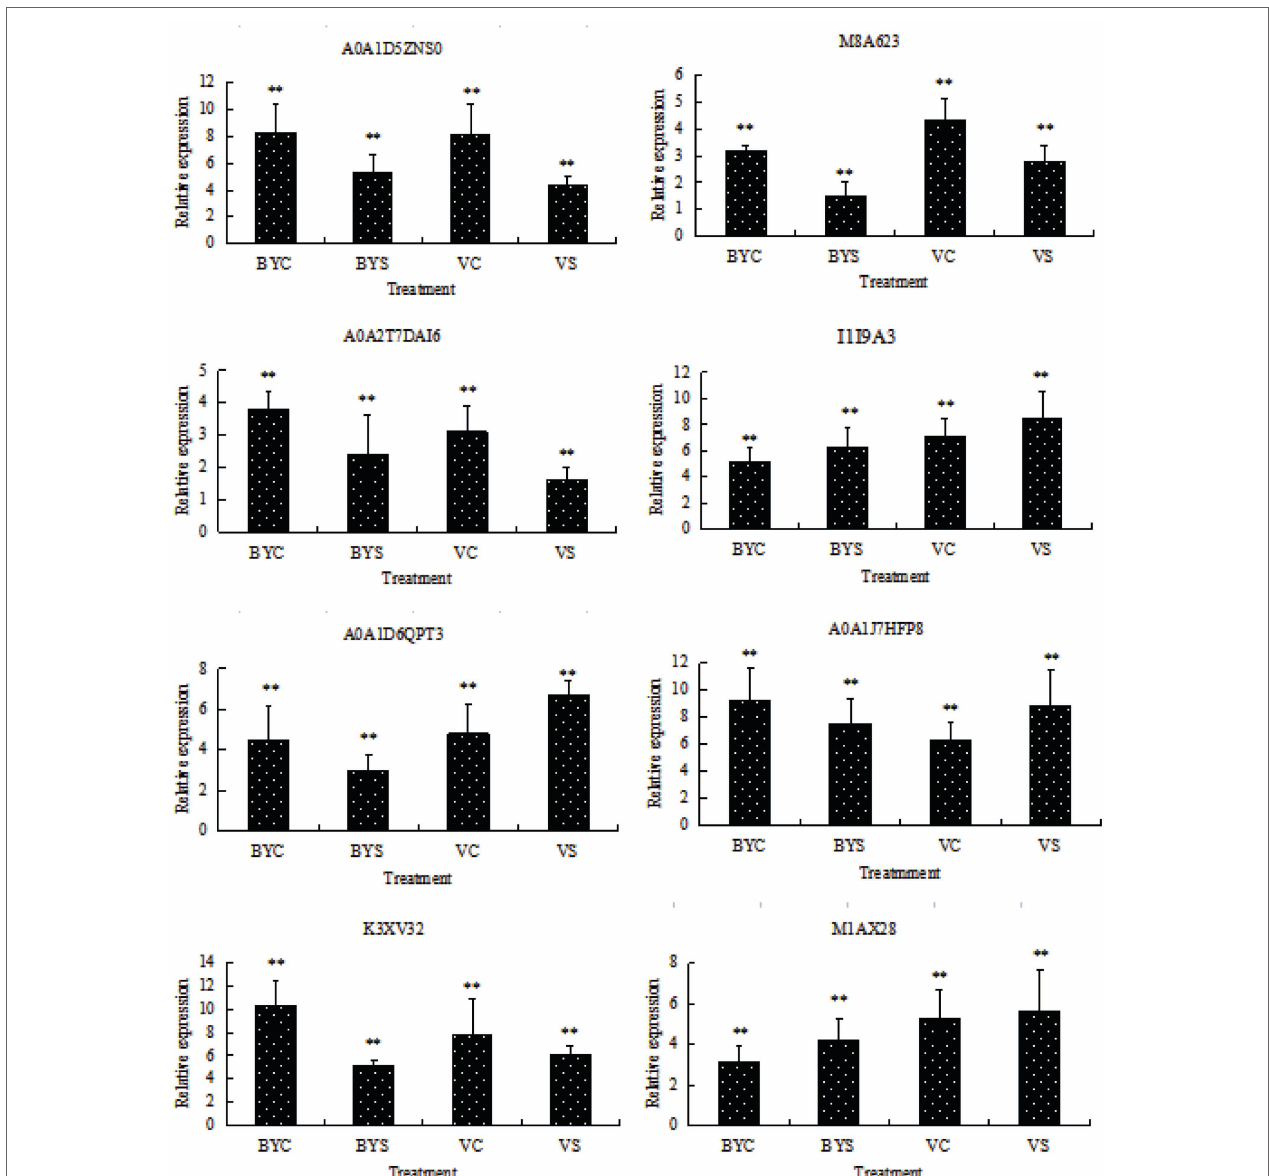
FIGURE 6 | Gene expression analysis of DEPs by qRT-PCR. BYC and VC represent the untreated (CK) samples of Bai5 and Vao-9; BYS and VS represent the salt treated samples of Bai5 and Vao-9. Data given in form of mean ± SE, the significant difference determined by One-way ANOVA (Duncan’s test, ** p <